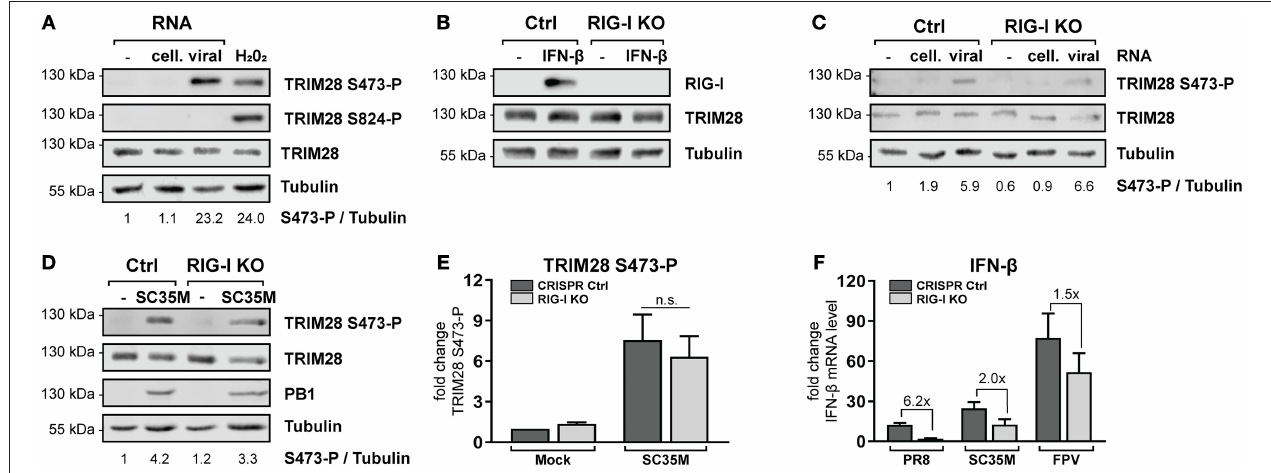
FIGURE 4 | TRIM28 S473 phosphorylation is induced by viral RNA in a RIG-I independent manner. (A) A549 cells were transfected with 1 µ g viral or cellular RNA. Lysates were harvested 4h p.t. and TRIM28 S473 and S824 phosphorylation was analyzed by western blot. As a control, cells were treated with 250 µ M H 2 O 2 for 3h. (B) Western blot of A549 RIG-I KO cells treated for 24h with 500 U/ml IFN- β . (C) RIG-I KO cells were transfected with 500 ng viral or cellular RNA. TRIM28 S473 phosphorylation was monitored by western blot. (D) Western blot of TRIM28 S473 phosphorylation in RIG-I KO cells infected with SC35M for 10h at an MOI of 20. (E) Densitometric quantifications of S473 phosphorylation in RIG-I KO cells infected as in (D) . TRIM28 S473-P levels were normalized to tubulin intensities. Results are plotted as mean n -fold change ( ± SEM) over mock-infected cells. n.s. p > 0.03; two-way ANOVA; Tukey’s multiple comparisons test. (F) Infection of RIG-I KO cells with PR8, SC35M or FPV at an MOI of 5. Total RNA was isolated 8h p.i. and IFN- β mRNA levels were measured by qRT-PCR. IFN- β levels are depicted as mean n -fold change ( ± SEM) over mock-infected